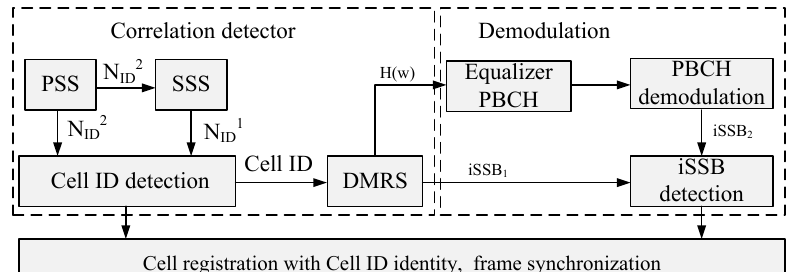
Fig. 2. Radioframe sycnrhonization